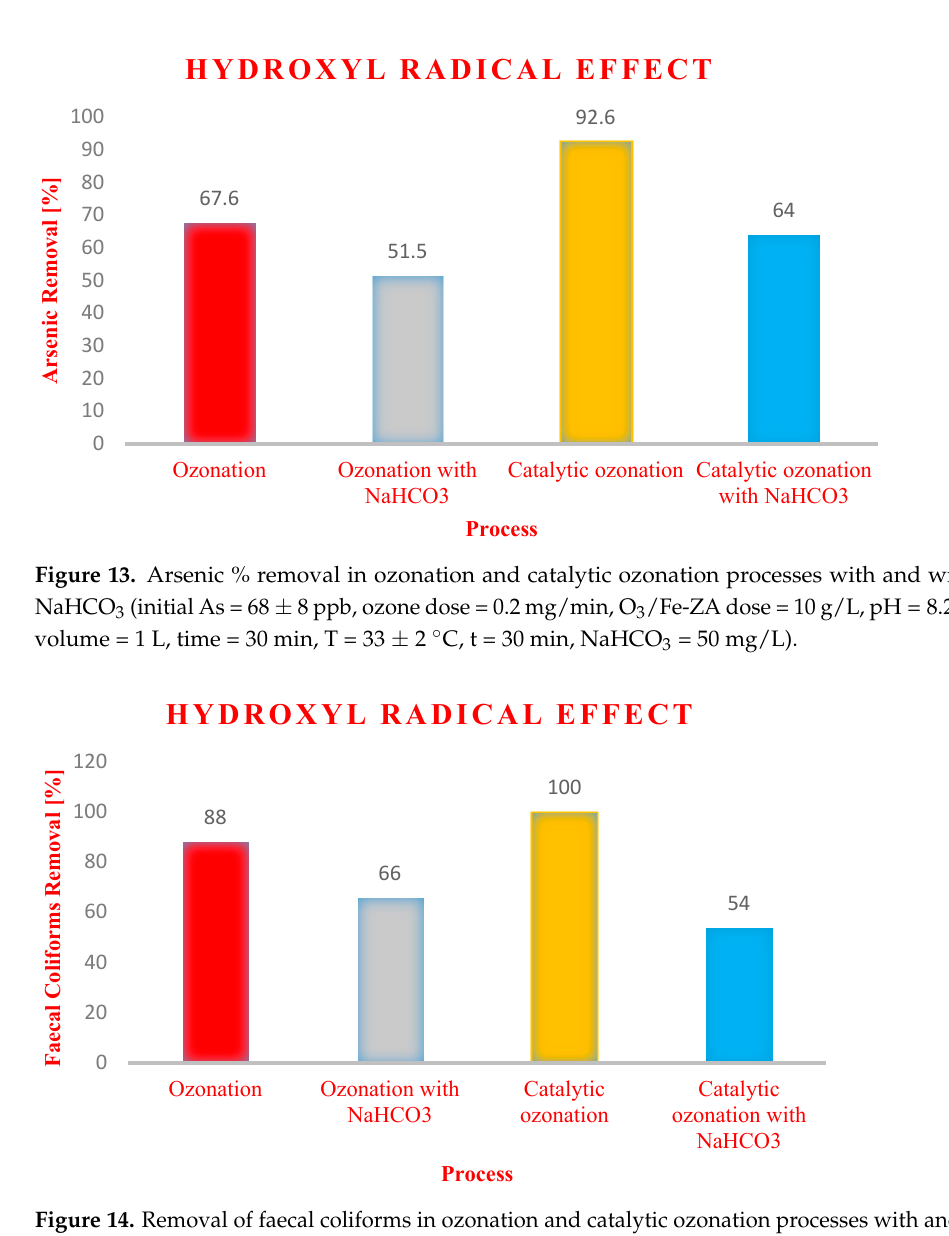
Figure 14. Removal of faecal coliforms in ozonation and catalytic ozonation processes with and with- out NaHCO 3 (initial faecal coliforms = 16 ± 4 MPN/100 mL, ozone dose = 0.2 mg/min, Fe-ZA dose =10 g/L, pH = 8.2 ± 0.3, volume = 1 L, time = 30 min, T = 33 ± 2 ◦ C, t = 15 min, NaHCO 3 = 50